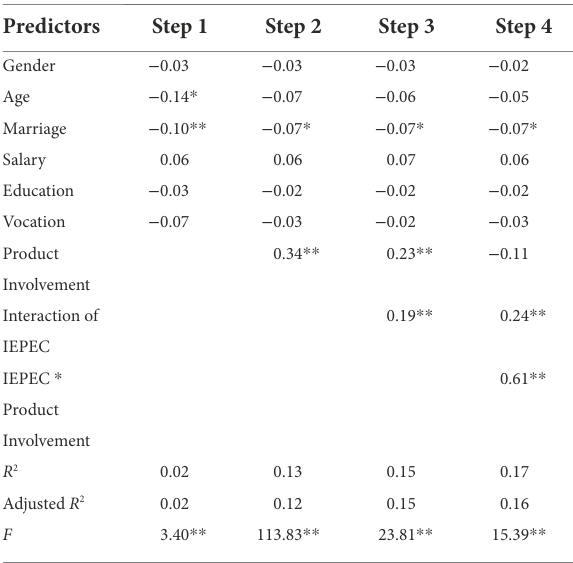
TABLE 9 Results of product involvement as a moderating role between virtual anime endorser-product incongruence and purchase intention.